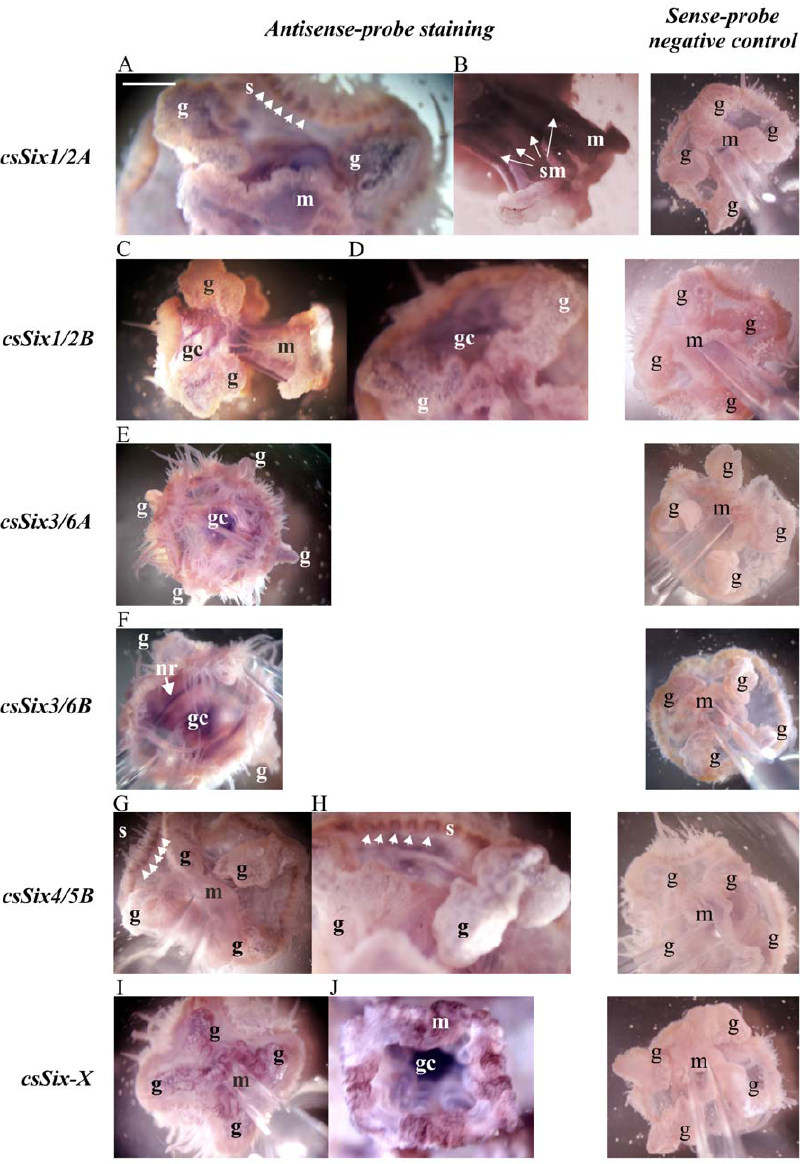
Figure 4. Expression analysis of CraspedacustasowerbyiSix genes. Violet or dark red coloring (depending on light intensity and conditions of the documentation process) show sites of expression of particular genes. (A) csSix1/2A expression in gonads (g), statocysts (s) and gastric cavity (gc), (B) four smooth muscle strands (sm) along with the tubular part of manubrium (m), (C, D) csSix1/2B expression at low level in gonads, at high level in gastric cavity except for manubrium opening, (E) csSix3/6A expression in gastric cavity, (F) expression of csSix3/6B in the nerve ring (nr) and gastric cavity except for manubrium, (G) csSix4/5B expression specifically in the statocysts, (H) detail of these structures shows a narrow strip of colored tissue around the tentacle bulb, (I, J) expression of csSix-X in gonads, gastric cavity and at the manubrium opening (frilly lips, mouth) in four zones concurring to four muscle strands in the manubrium, the site of csSix1/2A expression. Appropriate sense-probe negative controls are shown in the right column. A pipette tip was used for manipulation during the documentation and is present in some pictures. Scale bar (in A, white) is in (A), (B) (D), (H), (J) 70 m m and in (C), (E), (F), (G), (I) and all negative controls 160 m m.